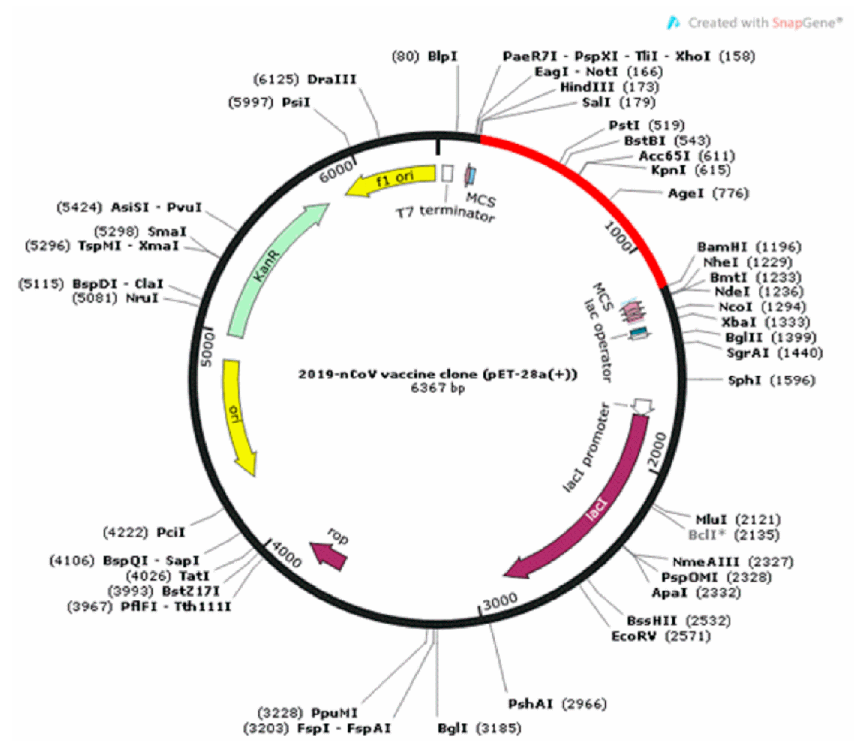
Figure 7. Expression of the final vaccine gene (Red) in a restriction cloning vector pET28a in E. coli host.